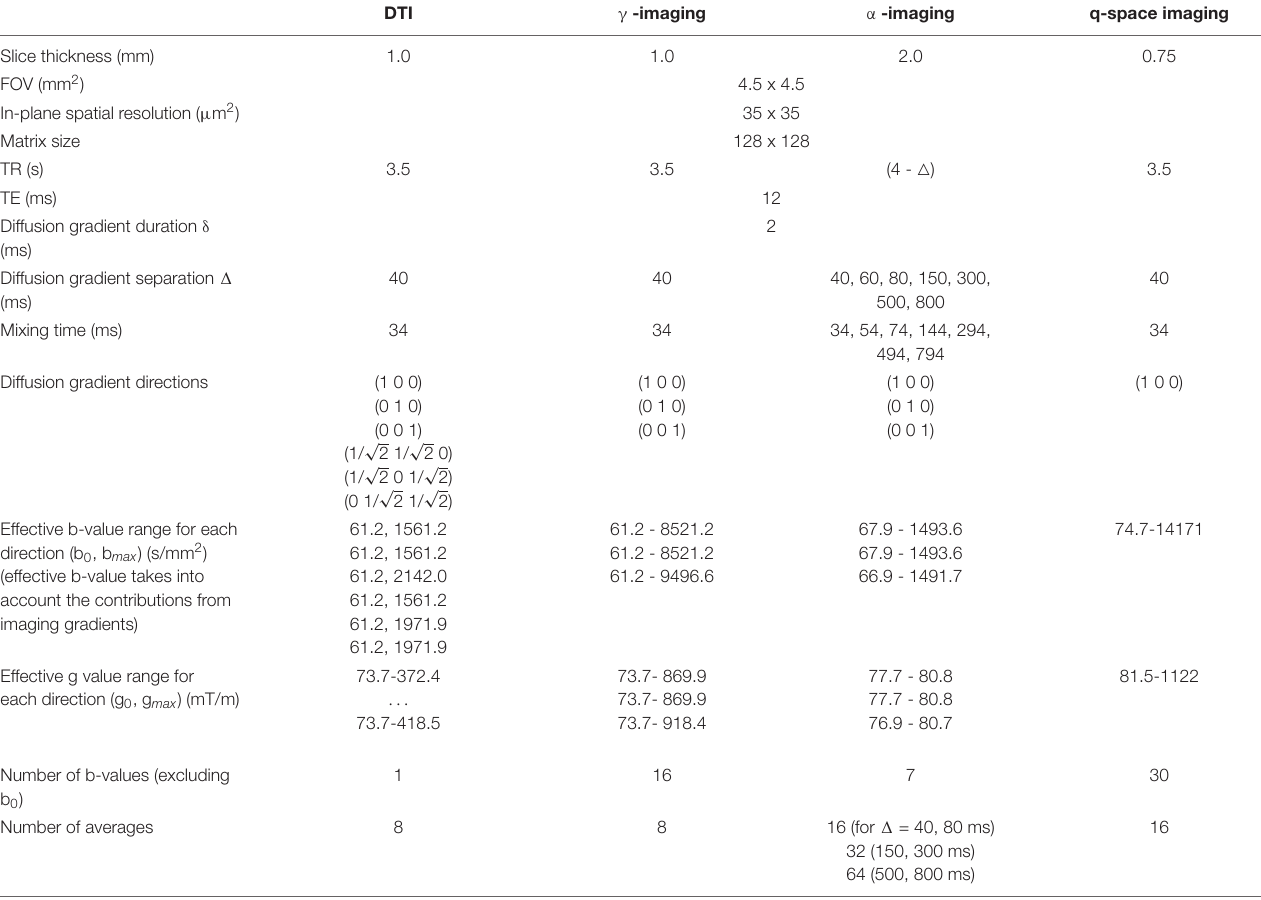
TABLE 1 | Acquisition parameters for the Pulse Gradient Stimulated Echo sequences. DTI γ -imaging α -imaging